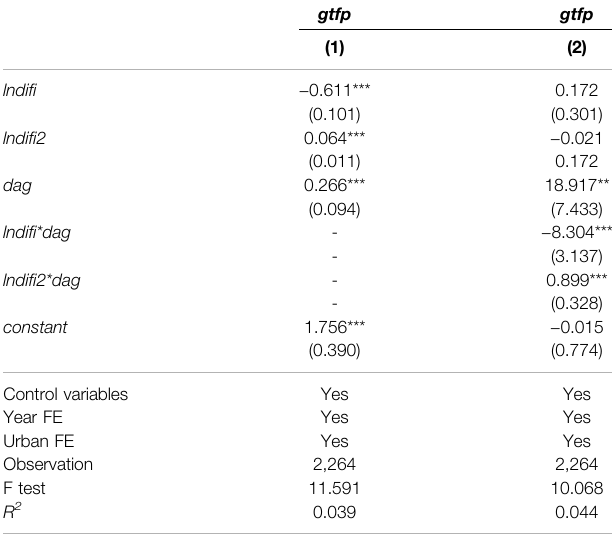
TABLE 13 | Regulatory effect of producer services